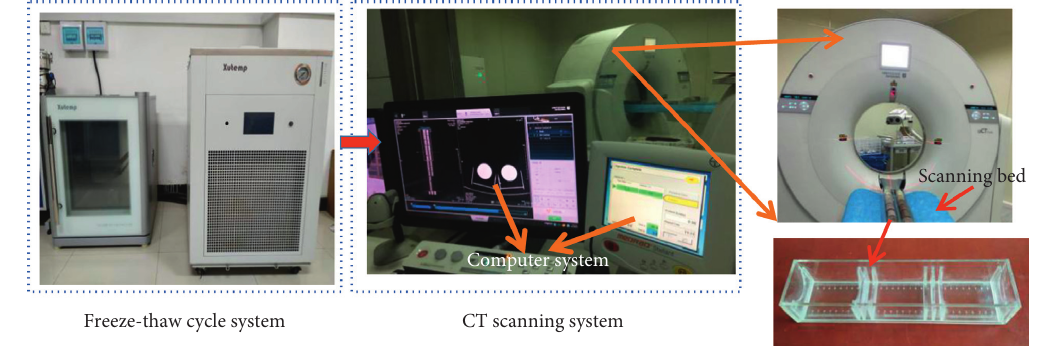
Figure 1: Experimental apparatus.